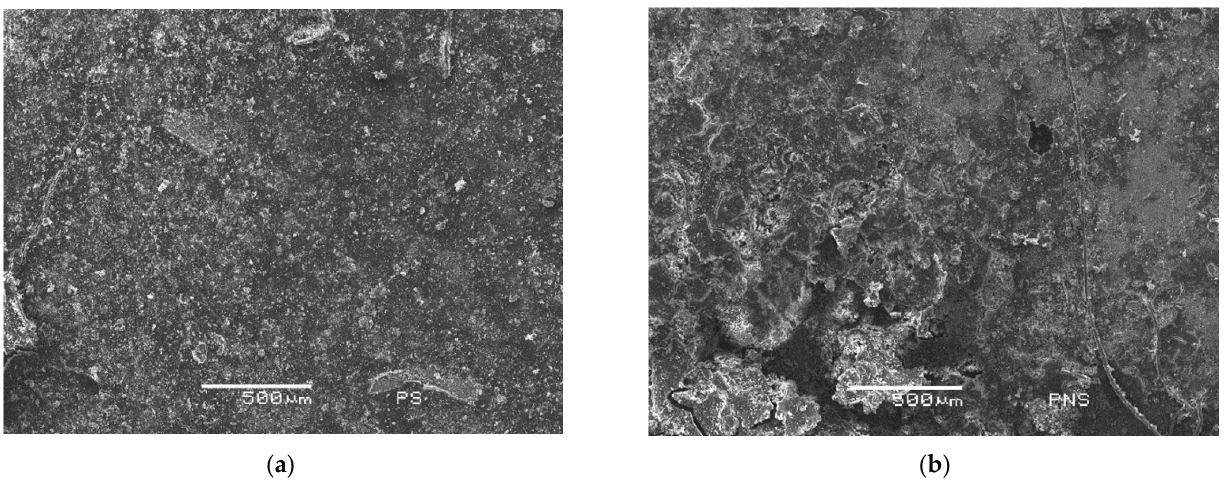
Figure 5. SEM images after 450 days and nine water drop tests. ( a ) an SP sample, and ( b ) an NSP